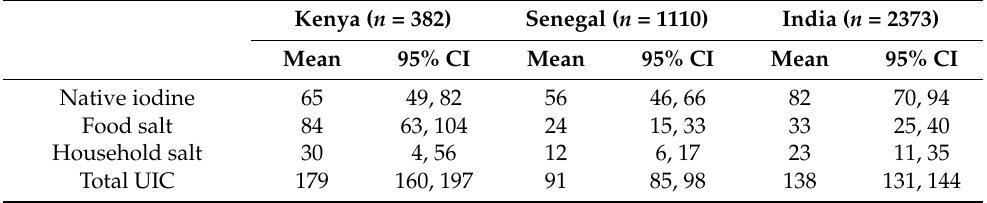
Table 3. UIC 1 portion estimates ( µ g/L; geometric mean, 95% CI) in WRA by country.